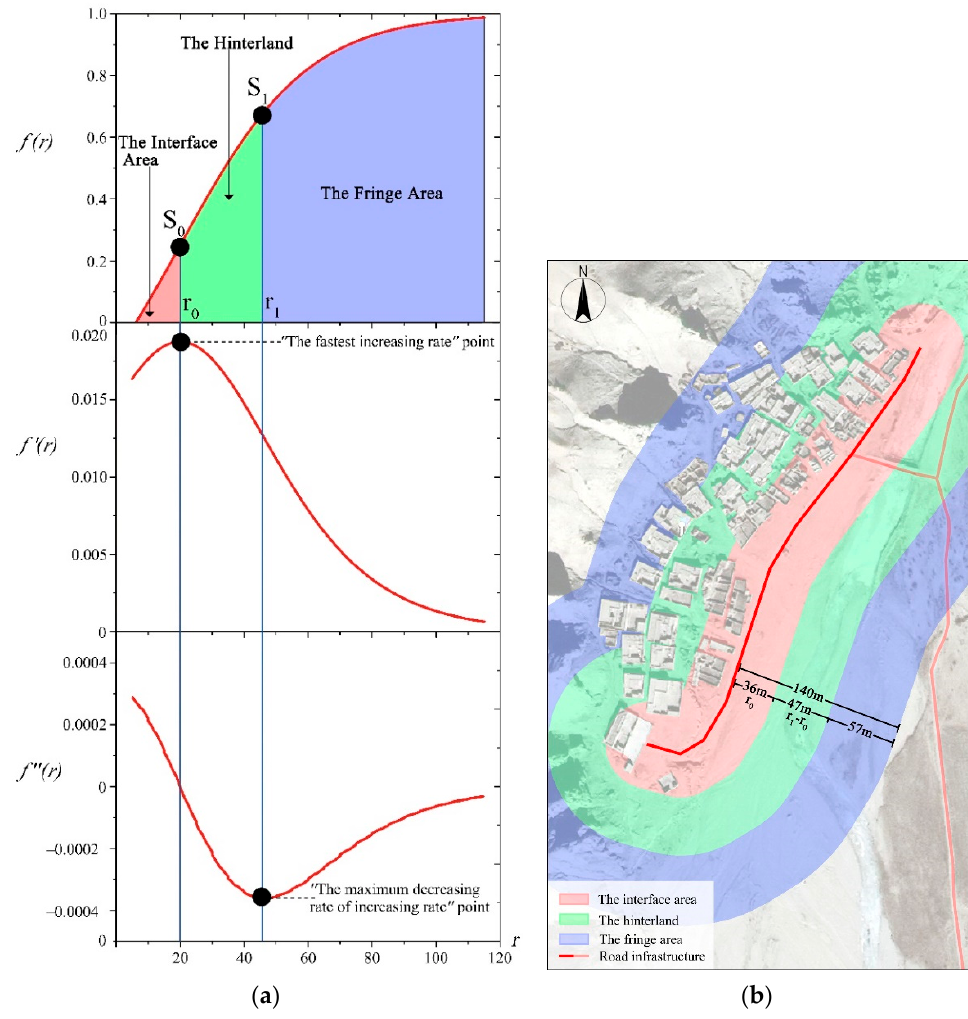
Figure 6. Derivative and threshold of rural settlement scale growth function. ( a ) The derivatives of scale growth function. ( b ) Spatial division of Rebujialin.